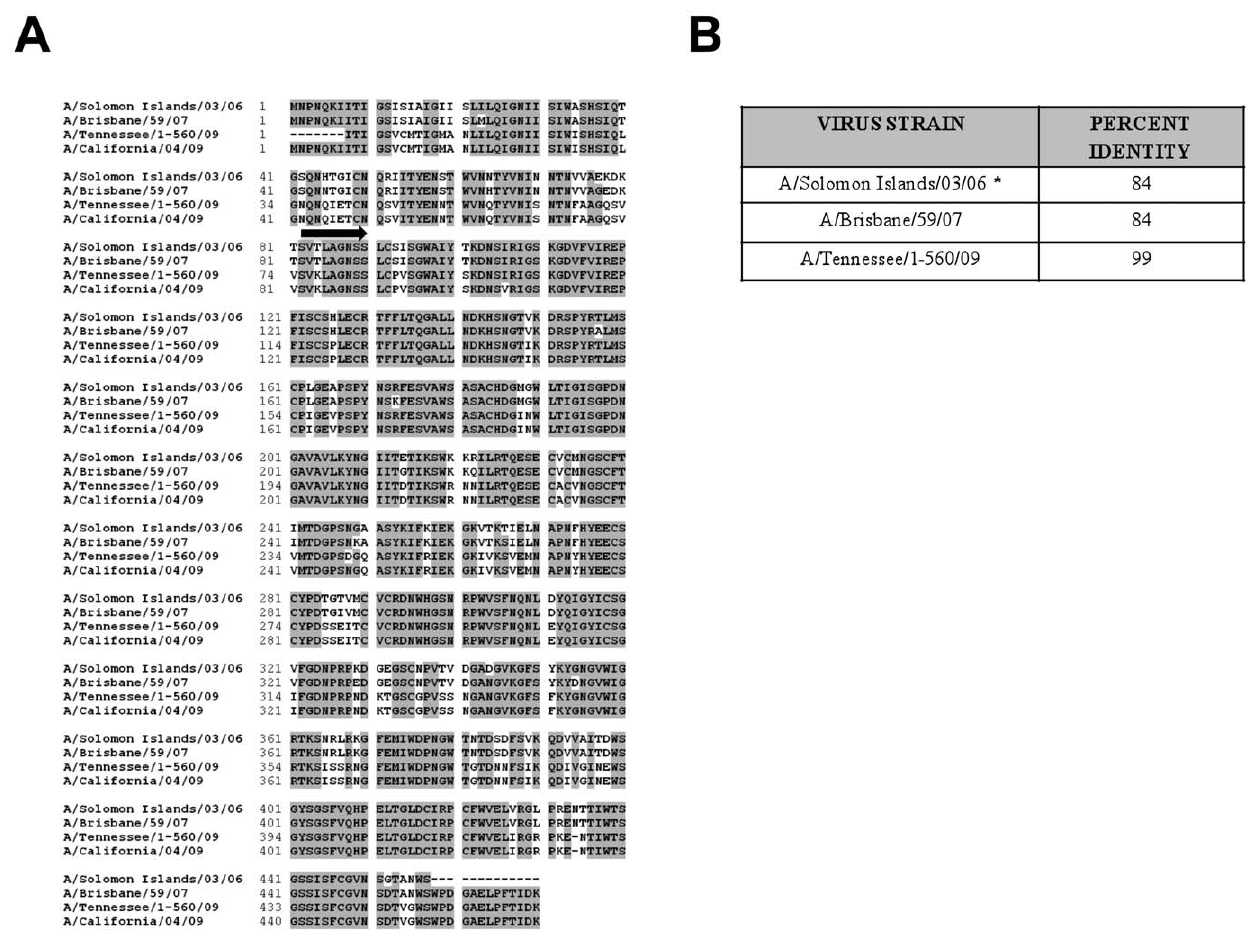
Figure 1. Alignment of amino acid sequences of the neuraminidase from seasonal or pandemic H1N1 influenza viruses. The GenBank sequences of the NA of Solomon, Brisbane, Tennessee and California were aligned using the clustalW alignment program (BioEdit software, Windows 95/98/NT). Numbers to the left of each line indicates amino acid position. Gaps in the alignment are represented as dashed lines. A) Sequences that are shaded in grey indicate identical amino acids between the full length NA of H1N1 viruses. The black arrow indicates the starting sequences of the ectodomain for each virus strain (residue 82 to end).* assumption that the NA sequence of Solomon has identical residues at C-terminus. B) The percent identity of the NA ectodomain between Solomon, Brisbane, Tennessee viruses compared to California was calculated using BioEdit.